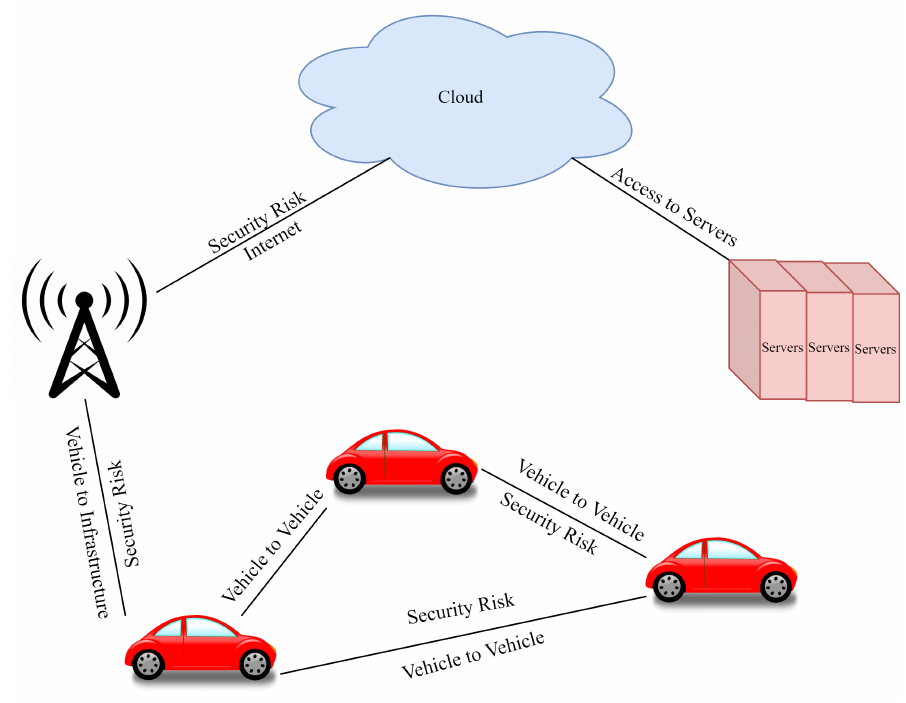
Figure 2. Key components and layers of an IoV